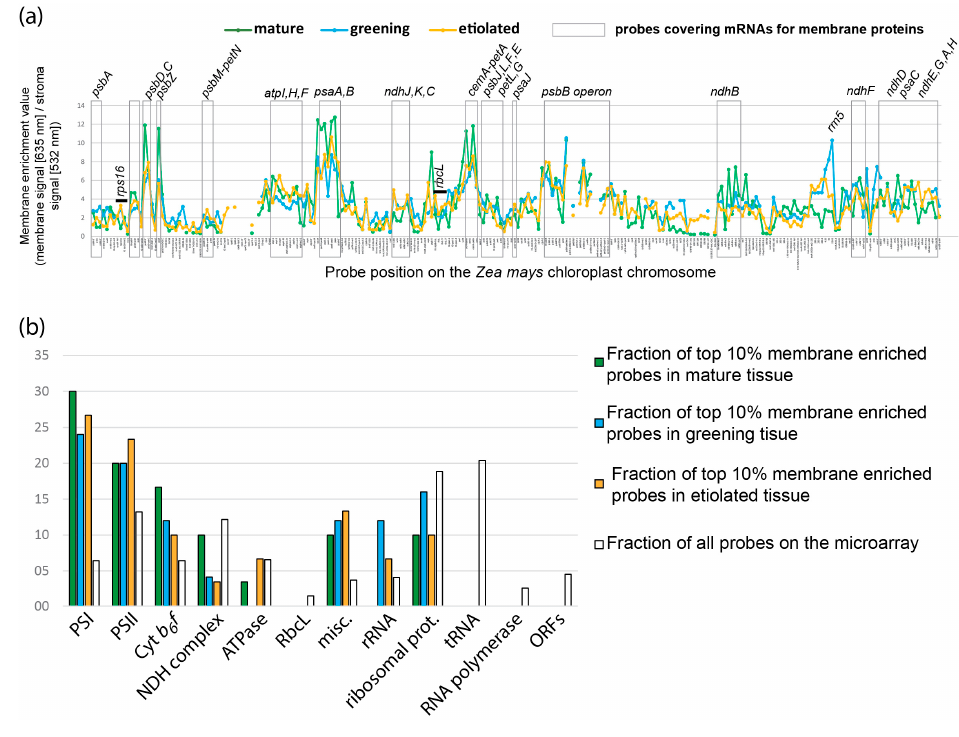
Figure 2. Microarray analysis of RNAs enriched at chloroplast membranes. ( a ) Membrane-enrichment of RNA along the chloroplast chromosome. Isolated chloroplast from maize seedlings grown at three different light regimes (leading to mature, greening, and etiolated plastids, respectively) were processed into stroma and membrane fractions. Two µg of RNA isolated from each fraction were differentially labeled and hybridized to a microarray representing the maize chloroplast genome in a tiling fashion. The ratio of membrane versus stroma signal was plotted against the genomic position on the Zea mays chloroplast genome (acc. NC_001666). The graphs shown represent four